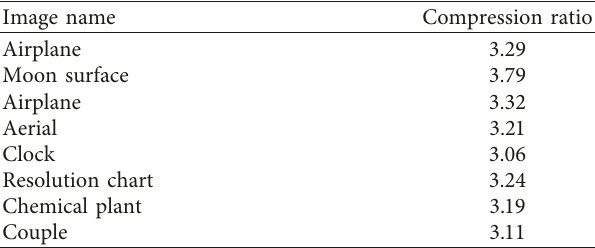
(b), y (c), and the decrypted frame 0 0 Table 2: Compression ratio results.